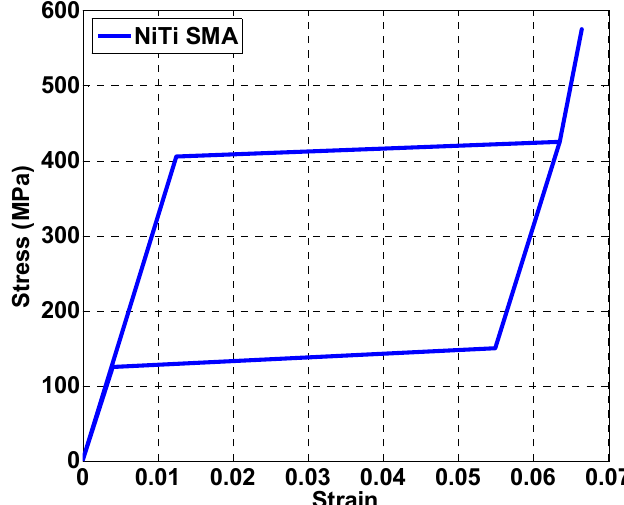
Figure 4. Superelastic behavior of NiTi SMA.